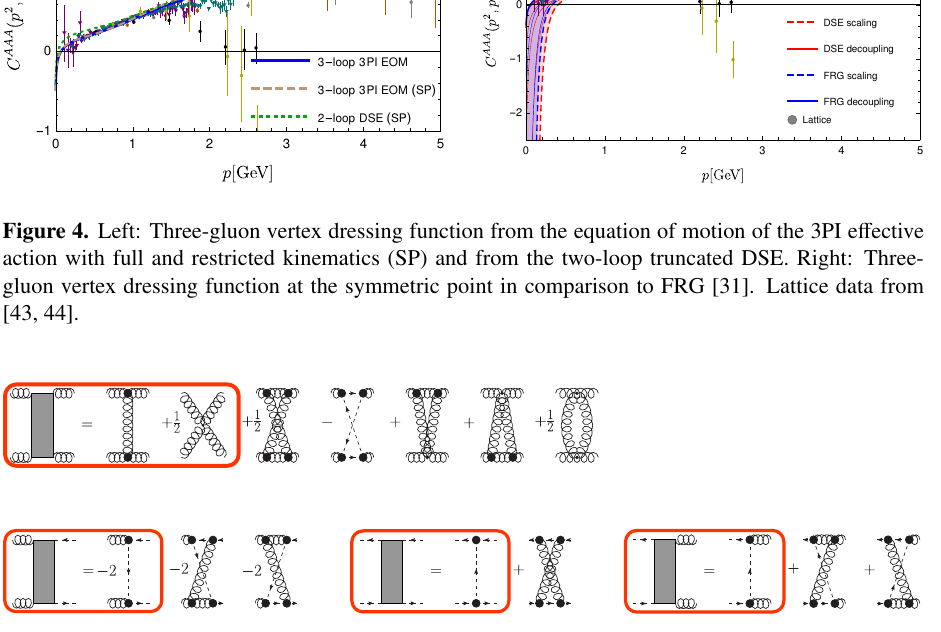
Figure 5. Interaction kernels from the three-loop 3PI e ff ective action. All propagators are dressed; black disks represent dressed vertices. The red rectangles denote the main